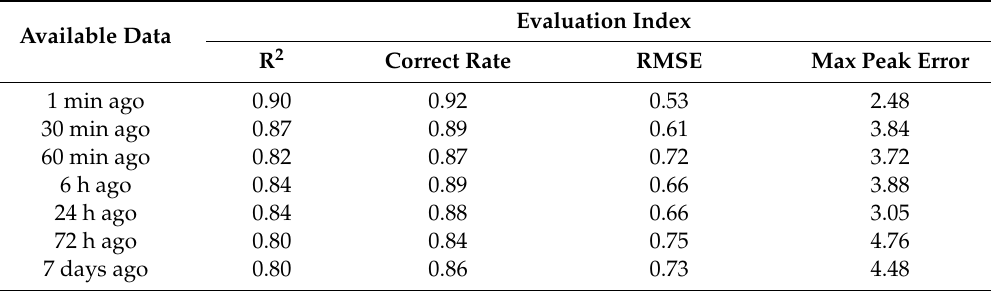
Table 21. Evaluation index based on the time before stopping